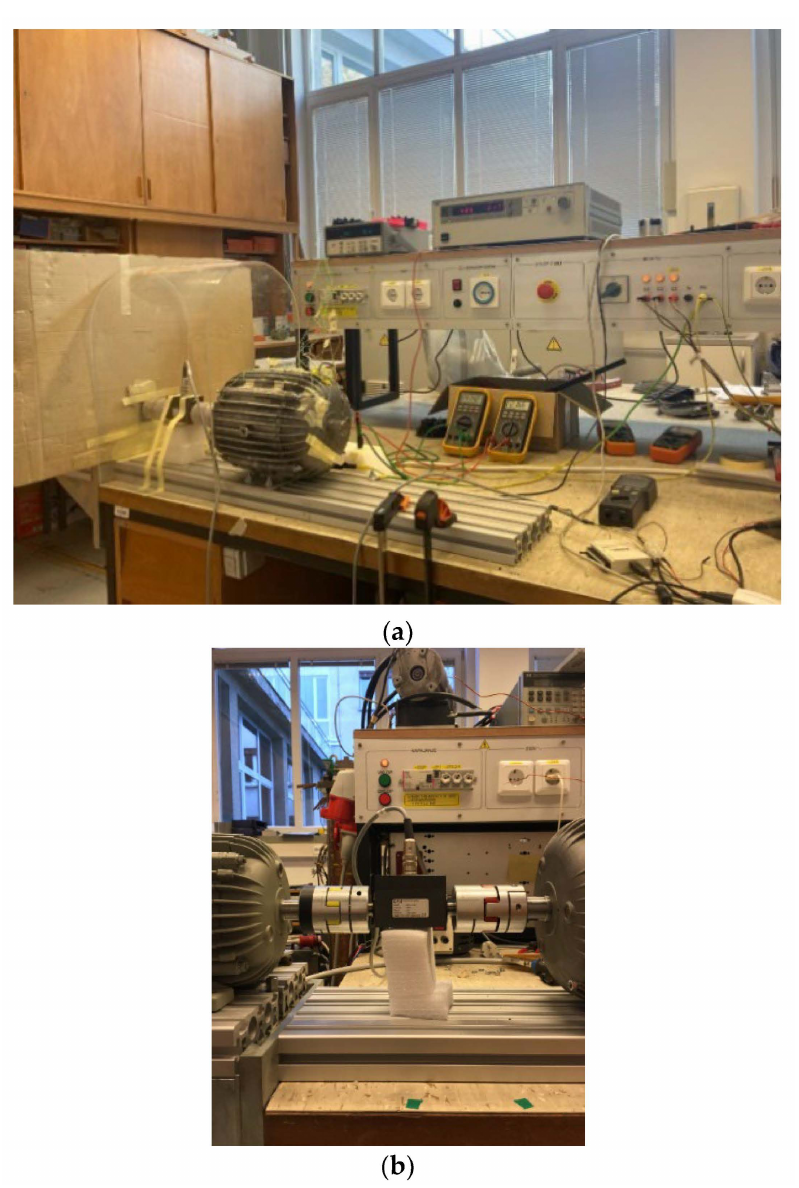
Figure 2. ( a ) Experimental setup configuration; ( b ) mechanical coupling between the drive motor and experimental